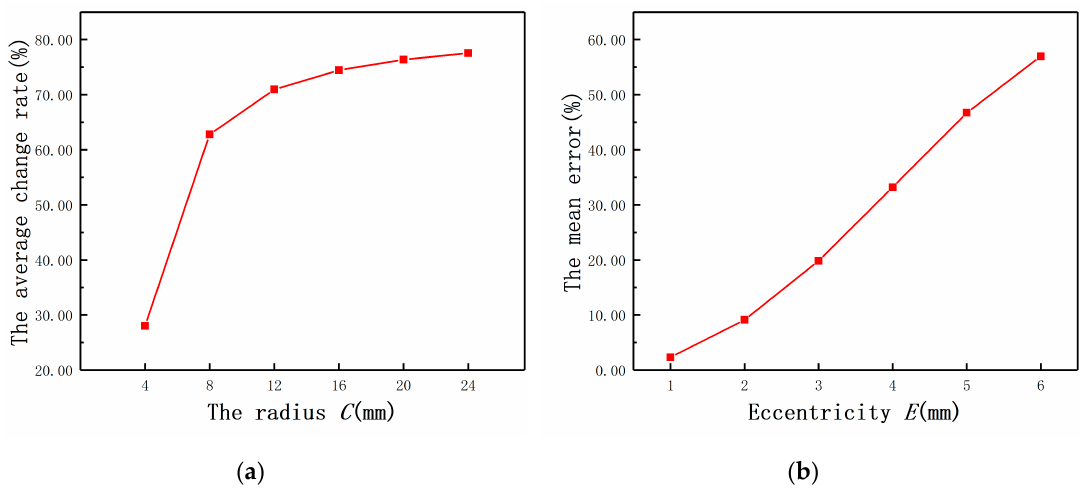
Figure 4. ( a ) The average change rates of B P under di ff erent radii; ( b ) the mean errors of B P under different eccentricities.